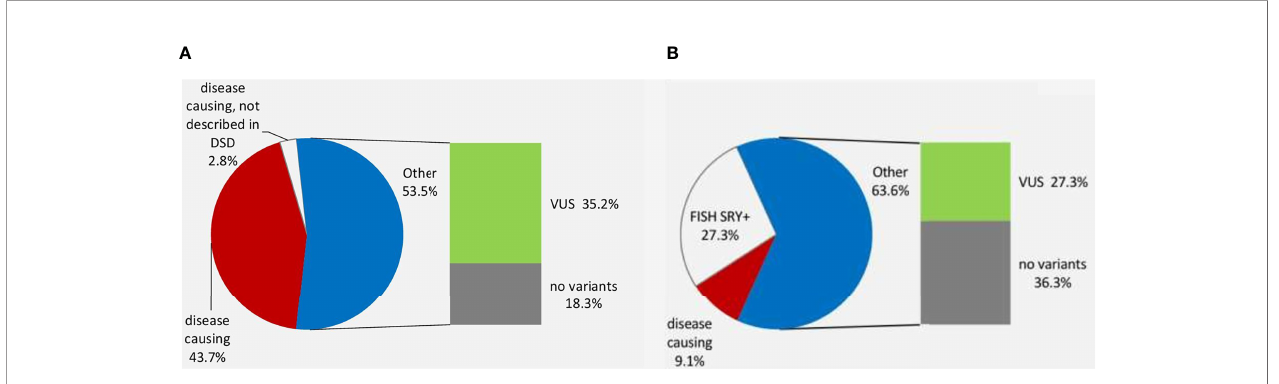
FIGURE 2 | The genetic diagnosis of 46, XY DSD (A) and 46,XX DSD (B)